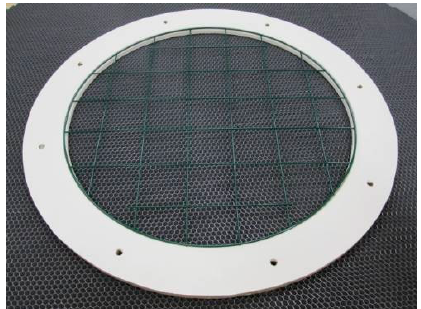
Figure 7. Wind tunnel grille to protect fan.